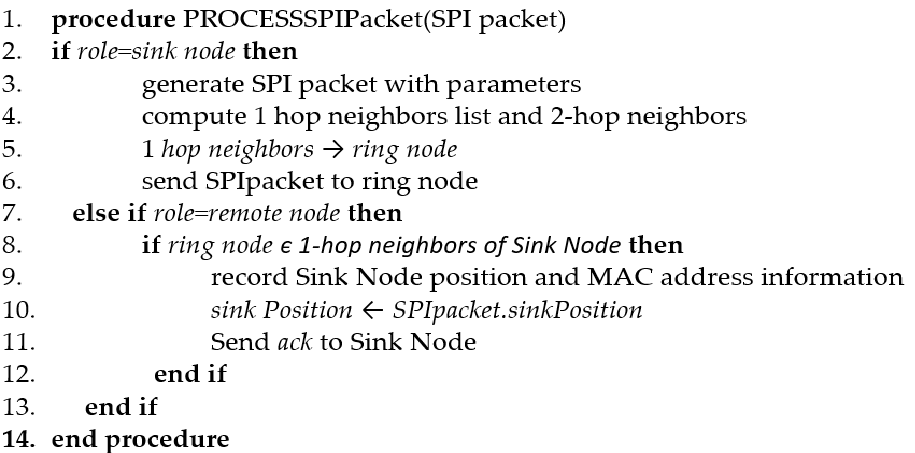
Figure 4. Frame format of the SPI (sink position information) for the ring node.